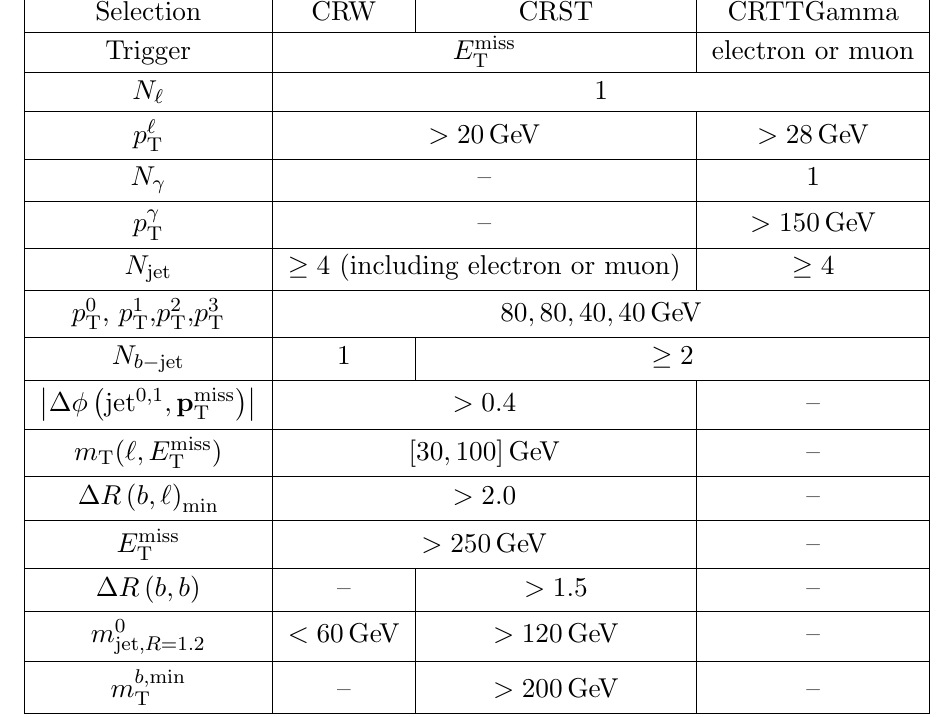
Table 7. Selection criteria for the common W + jets, single-top, and t (cid:22) t + (cid:13) control-region de(cid:12)nitions.